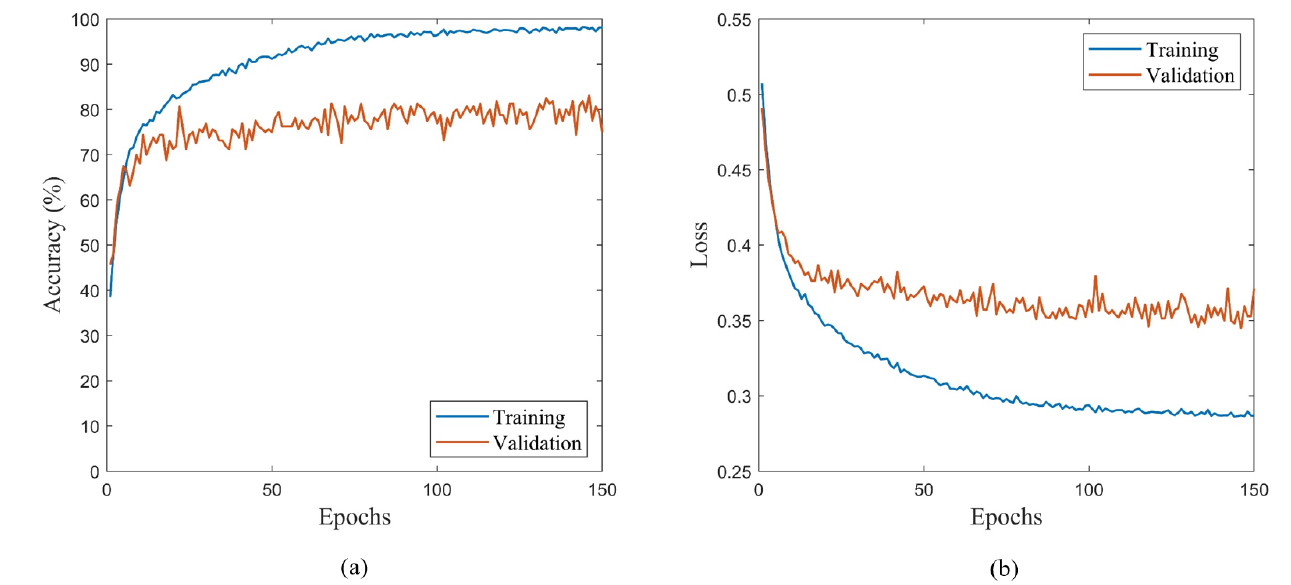
Figure 6. Training and validation ( a ) accuracy and ( b ) loss for the proposed